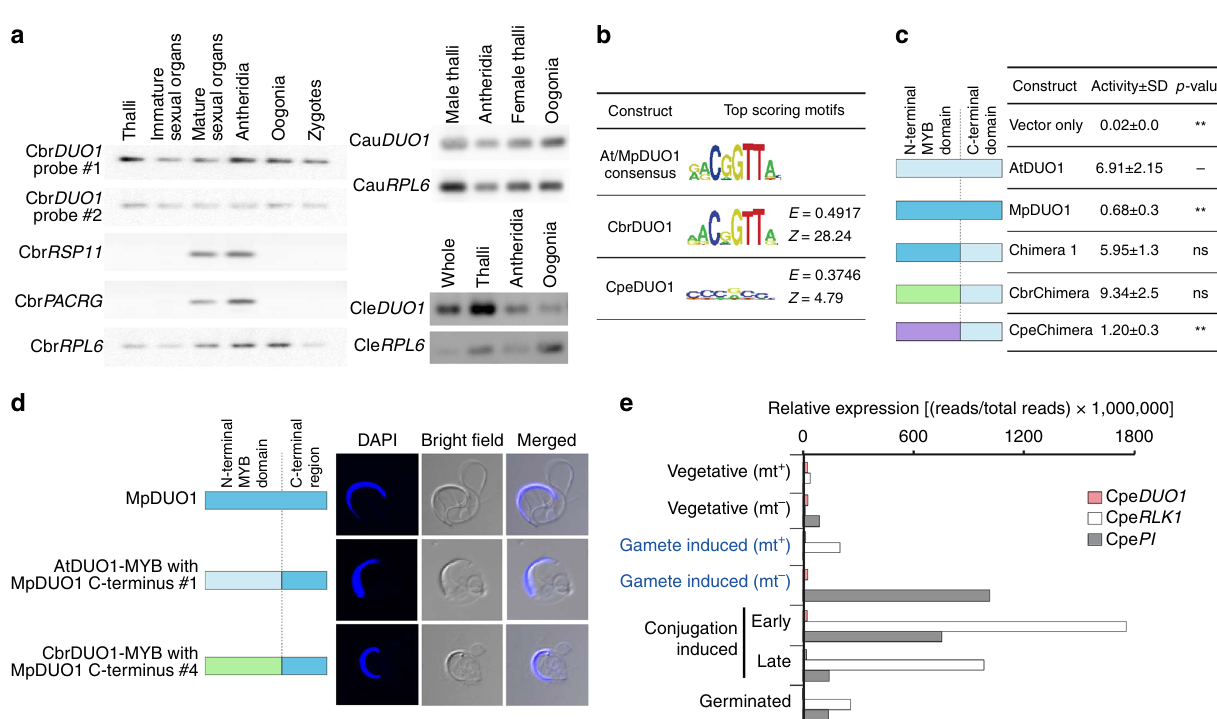
Fig. 7 Characterization of green algal DUO1 orthologs. a Expression pro fi les of DUO1 orthologs from three Chara species, C. braunii (Cbr), C. australis (Cau), and C. leptospora (Cle) representing two distant clades (subgenera) 41 . Ribosomal protein L6 ( RPL6 ) was used as the internal control. The expression of two fl agella component genes ( RSP11 and PACRG ) was also analyzed in C. braunii . Cbr DUO1 gene structure and ampli fi ed probed regions are shown in Supplementary Figure 7a. The whole untrimmed images are shown in Supplementary Figure 7b. Oogonia contain the egg. Antheridia contain developing sperm. Thalli are somatic vegetative tissue. b Position weight matrix representations of the top-scoring 8-mer DNA sequences bound by different MYB domains on a protein-binding DNA microarray. CpeDUO1 is DUO1 from Closterium peracerosum-strigosum-littorale complex (conjugating green alga). Numbers denoted on the right side of each motif represent the motif E- and Z-scores 19 . c In vivo transcriptional activation potentials of green algal DUO1 chimeras. DUO1 transcriptional activation potentials were measured by relative luciferase activity (right) ( n = 4; ** p < 0.01; ns, not signi fi cant; Student ’ s t- test). Schematic diagrams of constructs are color-coded light blue (AtDUO1), dark blue (MpDUO1), green (CbrDUO1), and purple (CpeDUO1). d The morphology of mature sperm of Mp duo1-1 ko complemented by the expression of WT MpDUO1 (top), AtDUO1-MYB domain with MpDUO1 C-terminus chimera (middle), and CbrDUO1-MYB domain with MpDUO1 C-terminus chimera (bottom). The blue signals indicate the DAPI stained nuclei. Constructs are color-coded as in c . e Expression pro fi les of Cpe DUO1 and sexual reproduction-speci fi c Cpe RLK1 and Cpe PI in Closterium peracerosum-strigosum-littorale complex. Stages equivalent to gametes in anisogamous plants are highlighted in blue. Relative expression ([reads per total sequenced reads] × 1,000,000) was